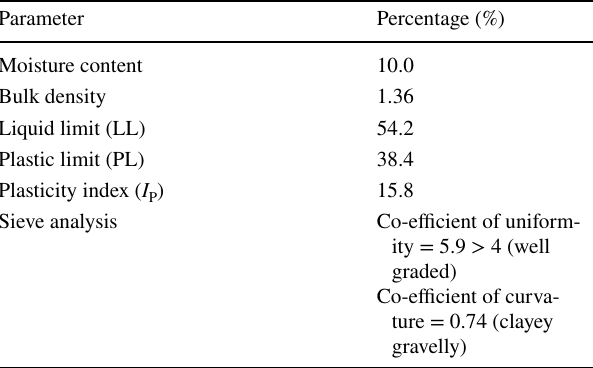
Table 1 Characteristics of soil collected from Parit Raja,